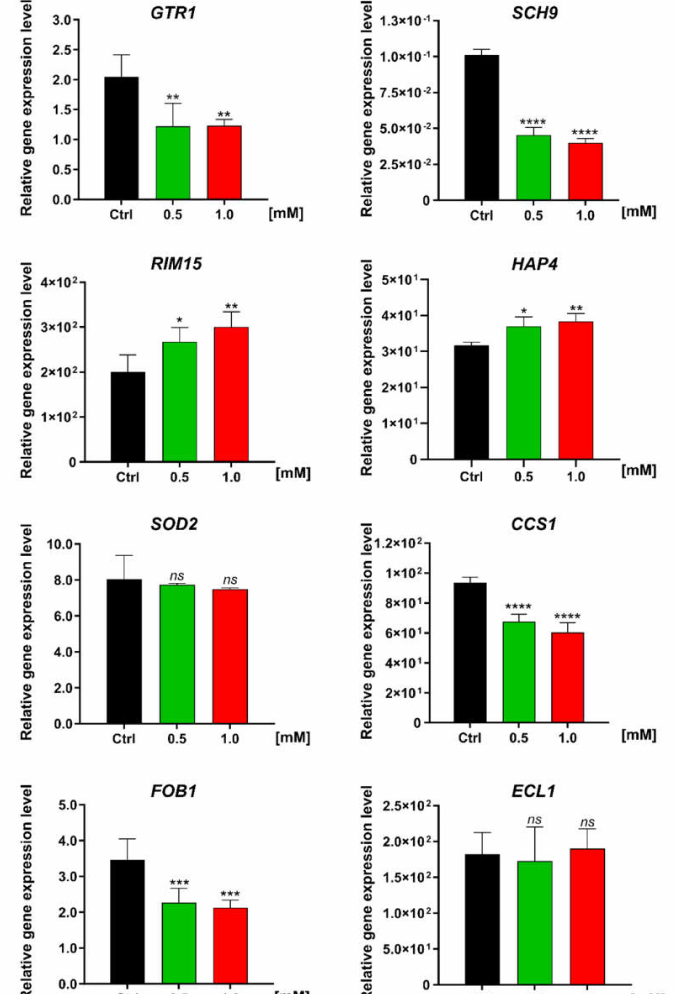
Figure 8. Changes in the expression of selected genes analyzed after treatment with 0.5 or 1.0 mM FC. Relative real − time PCR analysis was performed for the genes GTR1, SCH9, RIM15, HAP4, SOD2, CCS1, FOB1, and ECL1. Data are presented as mean ± SD of three biological replicates and three independent experimental repeats for each one. Statistical significance versus control (ANOVA): (ns) non − significant, (*) p < 0.05, (**) p < 0.01, (***) p < 0.001, (****) p <